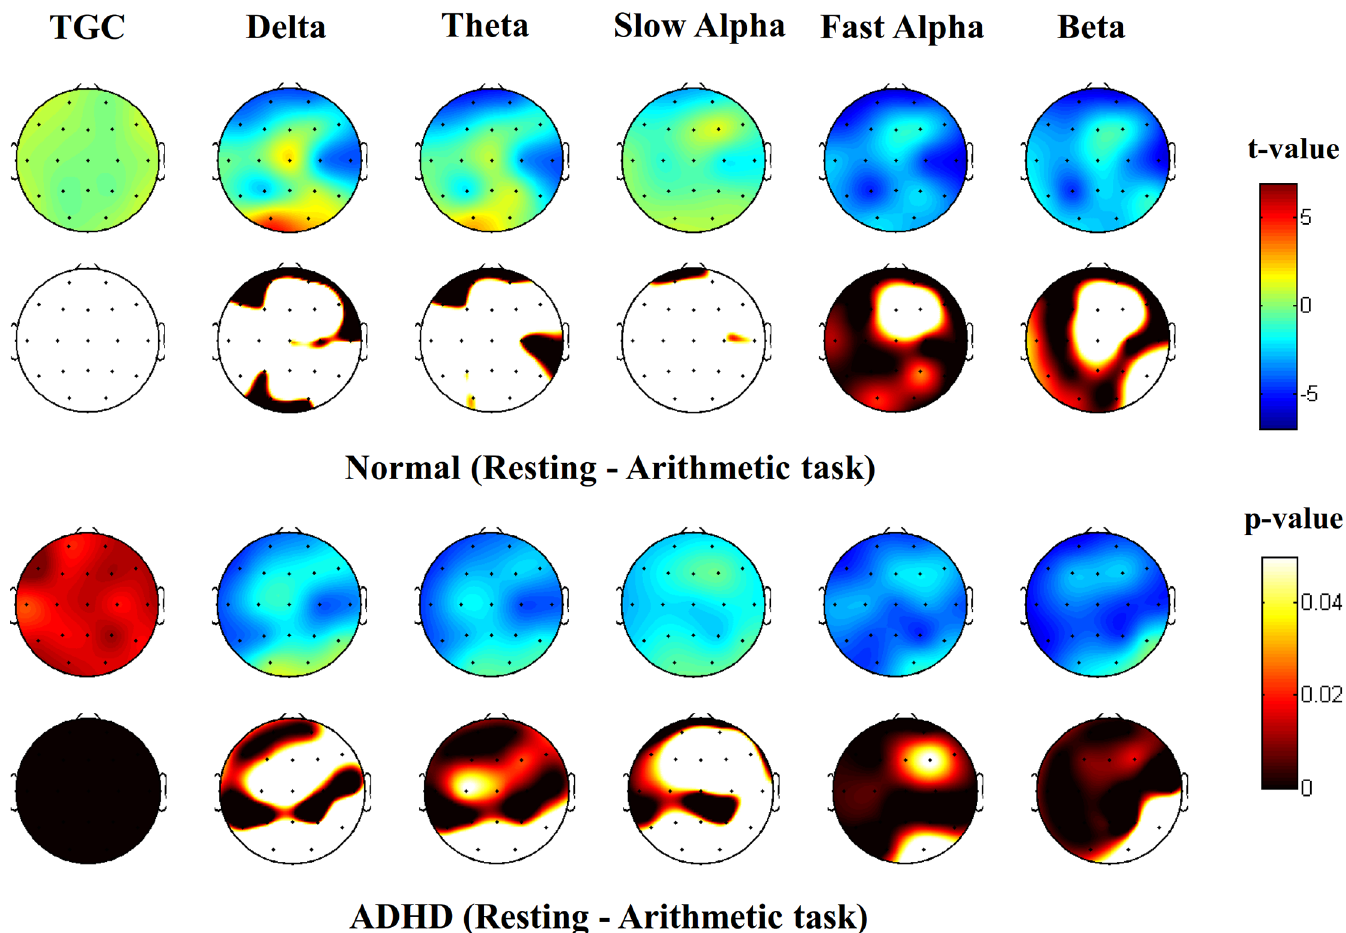
Fig 2. Topographic map of theta-gamma coupling (TGC). The upper topography denotes the topographical distribution of t-values (paired t-test). The lower topography denotes the topographical distribution of the corresponding p-values. ADHD, Attention Deficit/Hyperactivity Disorder.